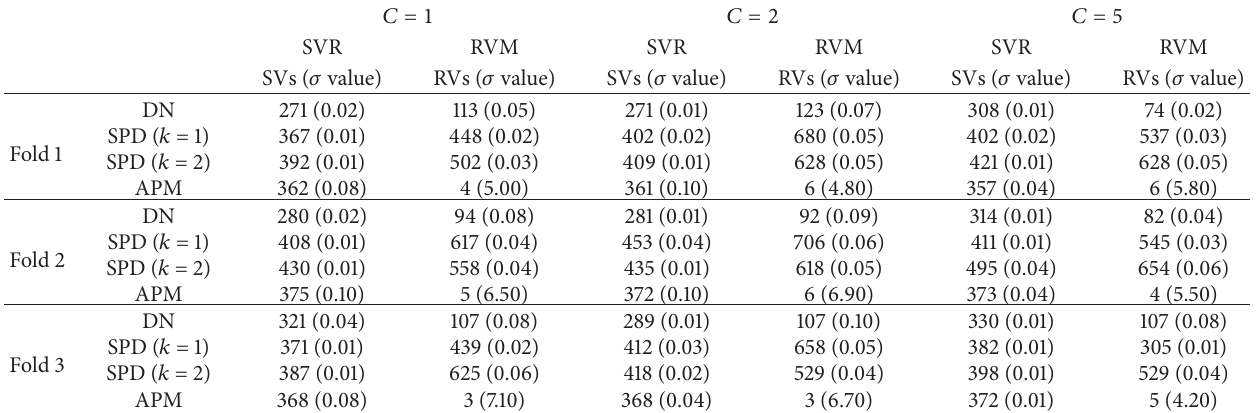
Table 2: The number of relevance vectors (RVs) and support vectors (SVs) for each model with DN, SPD, and APM and the selected 𝜎 values for each